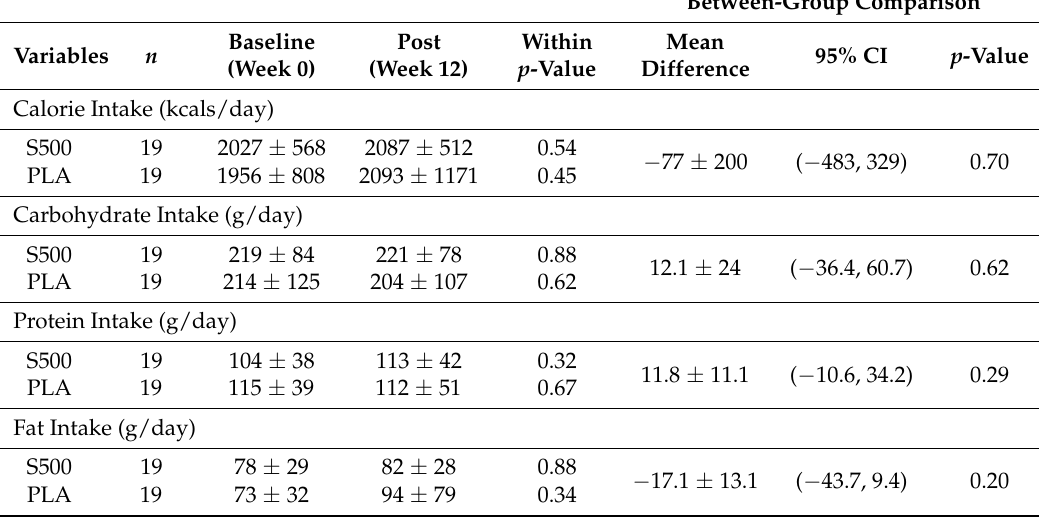
Table 3. Dietary intake data.